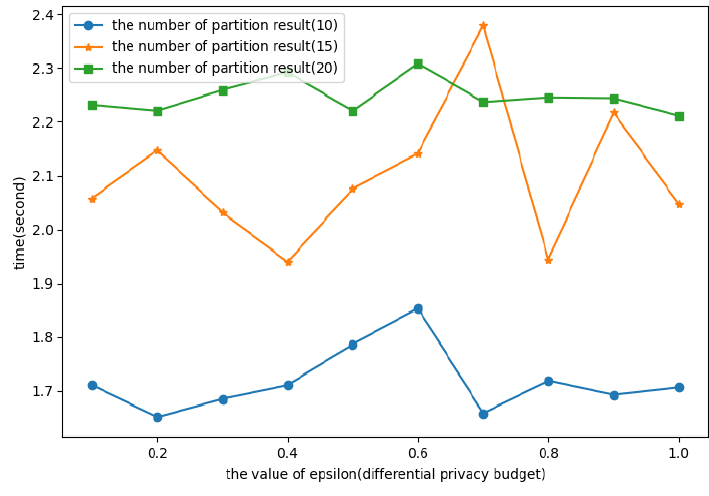
Figure 16. Time cost with different epsilon (Geolife dataset).